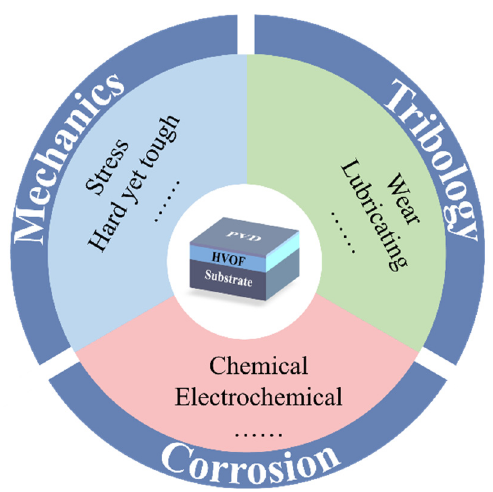
Figure 14. Properties of HVOF-PVD duplex coating, including mechanics, tribology, and